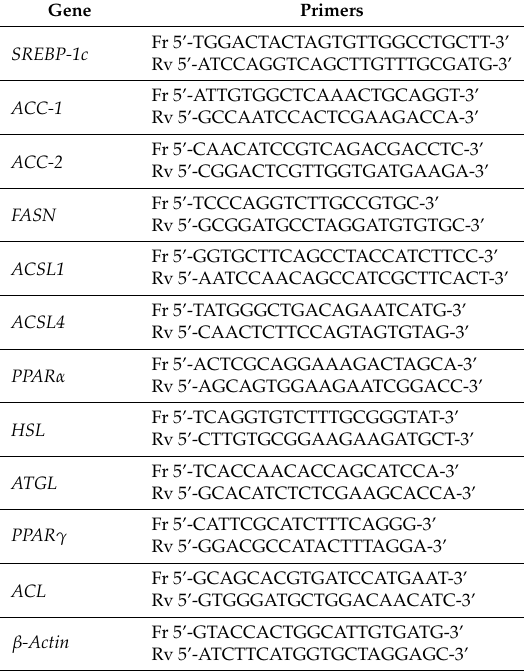
Table 4. Primers used for the real-time PCR analysis. The amplification efficiency and specificity were confirmed before real-time PCR